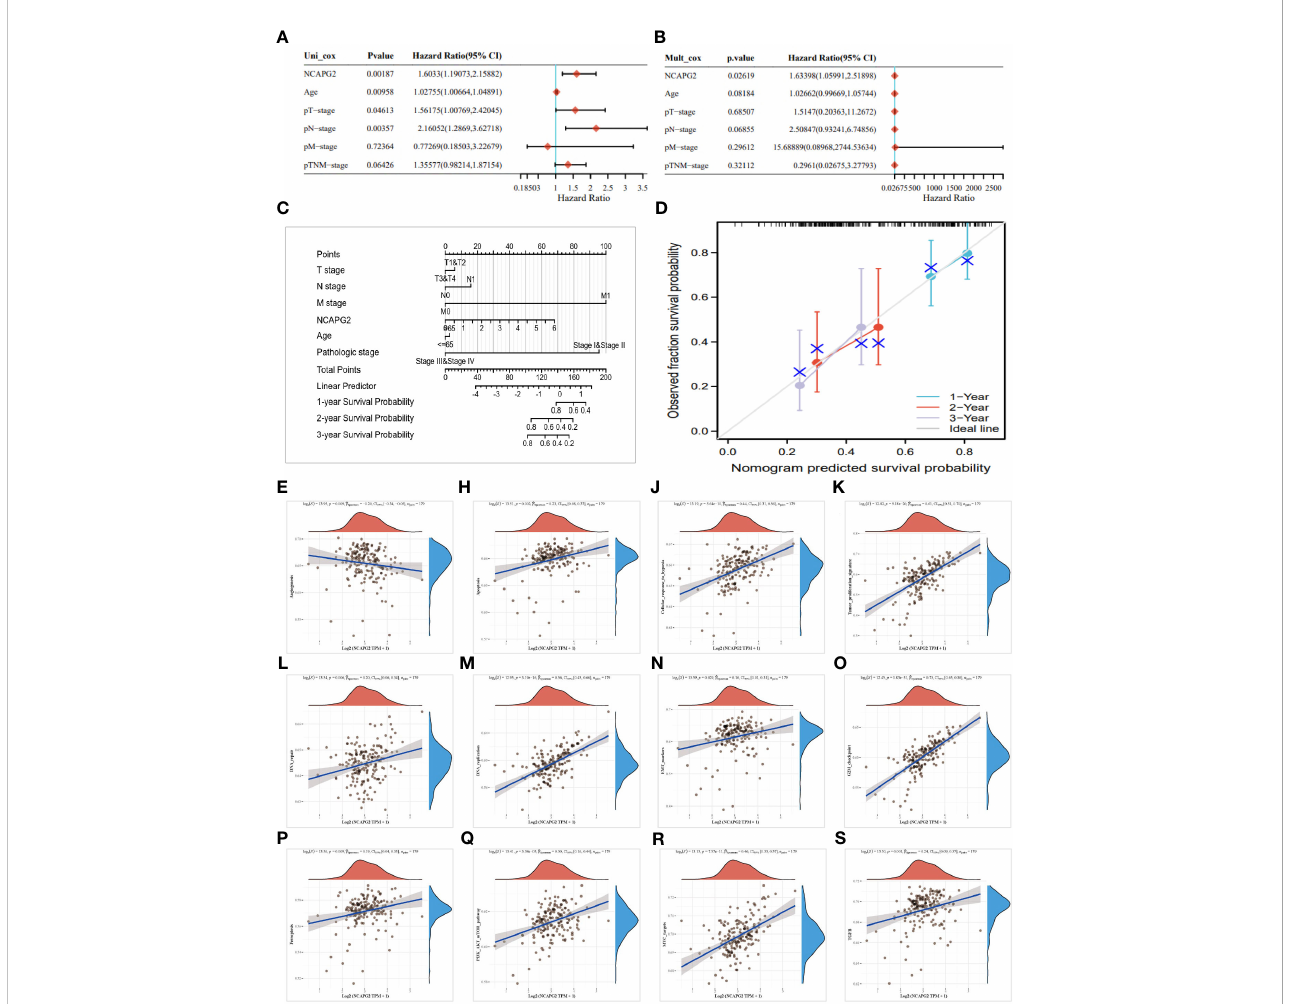
FIGURE 8 Analysis of the clinical relevance of NCAPG2 in pancreatic cancer. (A, B) Prognostic signi fi cance of NCAPG2 in pancreatic cancer by univariate and multifactorial COX analysis. (C) Nomogram based on NCAPG2 expression and pathological staging. (D) Correction analysis diagram of the nomogram. (E – S) GSVA pathway correlation